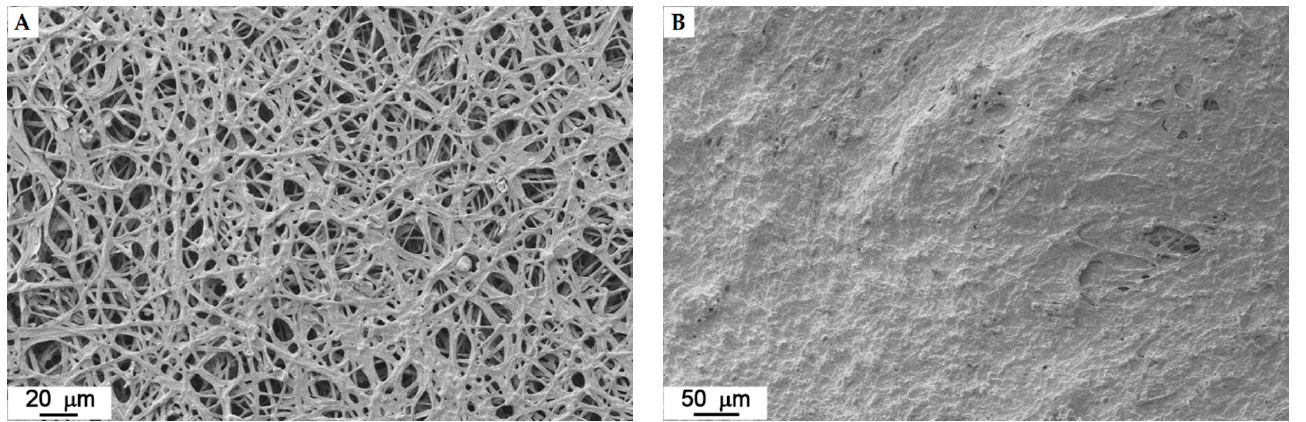
Figure 10. Fomitopsis iberica (10). Front ( A ) and back ( B ) of the mat obtained by patented method.